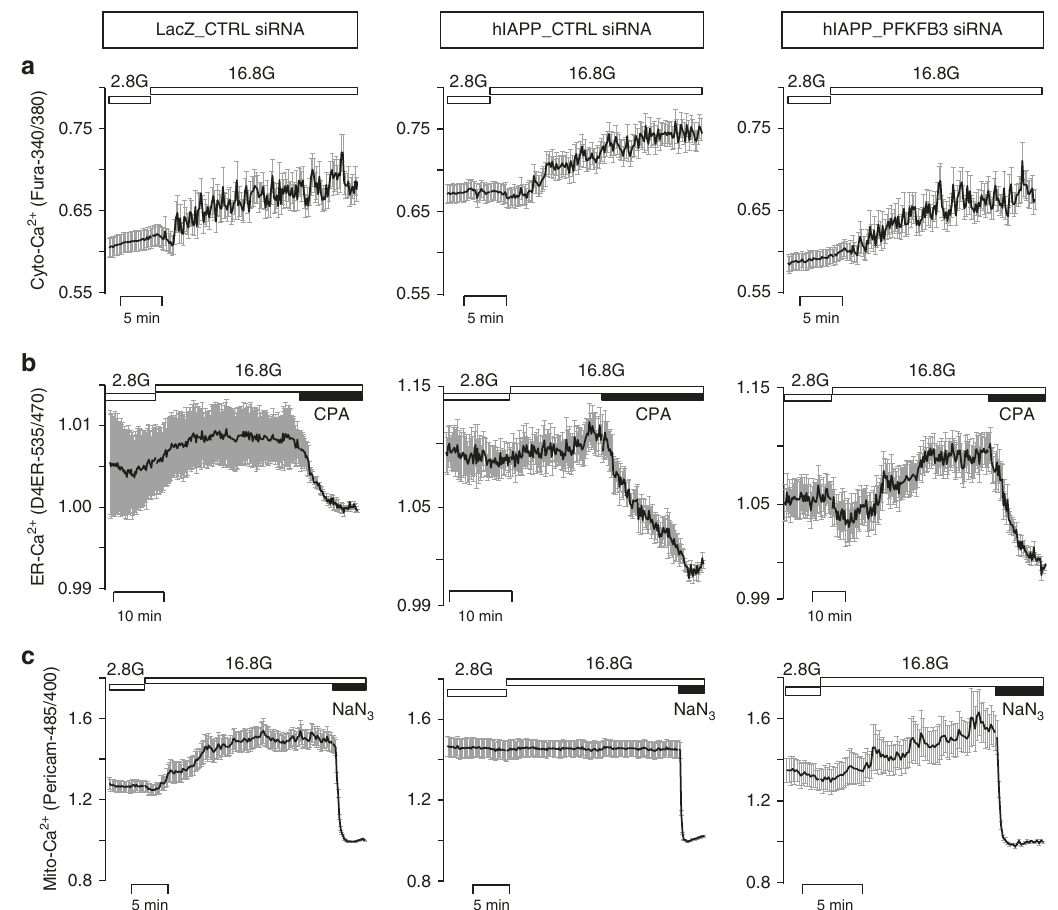
Fig. 8 PFKFB3 silencing restores Ca 2 + dynamics of cytosolic, ER and mitochondrial compartment. Average traces ± SEM of a cytosolic, b endoplasmic reticulum (ER), and c mitochondrial calcium in INS 832/13 cells overexpressing LacZ (LacZ_CTRL siRNA) or hIAPP in the presence or absence of PFKFB3 siRNA (hIAPP_PFKFB3 siRNA and hIAPP_CTRL siRNA, respectively) measured at low (2.8 mM, 2.8 G) and high (16.8 mM, 16.8 G) glucose. Cyclopiazonic acid (CPA) and sodium azide (NaN 3 ) have been added after measurement of [Ca 2 + ] in high glucose (16.8 mM) to establish the [Ca 2 + ] content in ER and mitochondria, respectively. Average Ca 2 + traces are presented from one of 3 ( n = 3) independent experiments. The vertical axis in LacZ_CTRL siRNA for D4ER 535/470 ratio has been shown within 0.99 – 1.015 AU to indicate the increment in average traces upon exposure to high (16.8 mM) glucose. Ca 2 + traces shown for ER and mitochondria were fi rst normalized to their respective nadirs, obtained in the presence of CPA or NaN